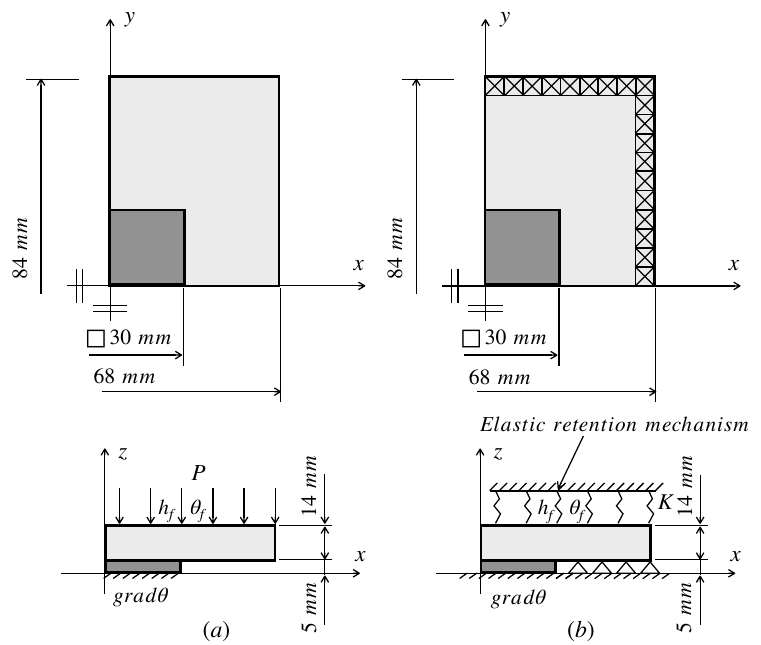
Figure 6. ( a ) Proposed geometry and initial boundary conditions. ( b ) New elastic boundary